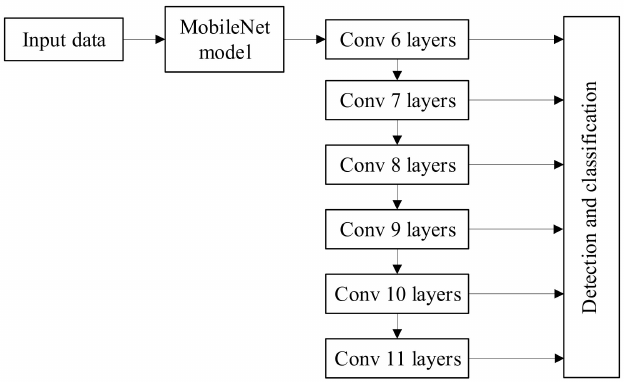
Figure 7. The MobileNet-SSD object detection model.